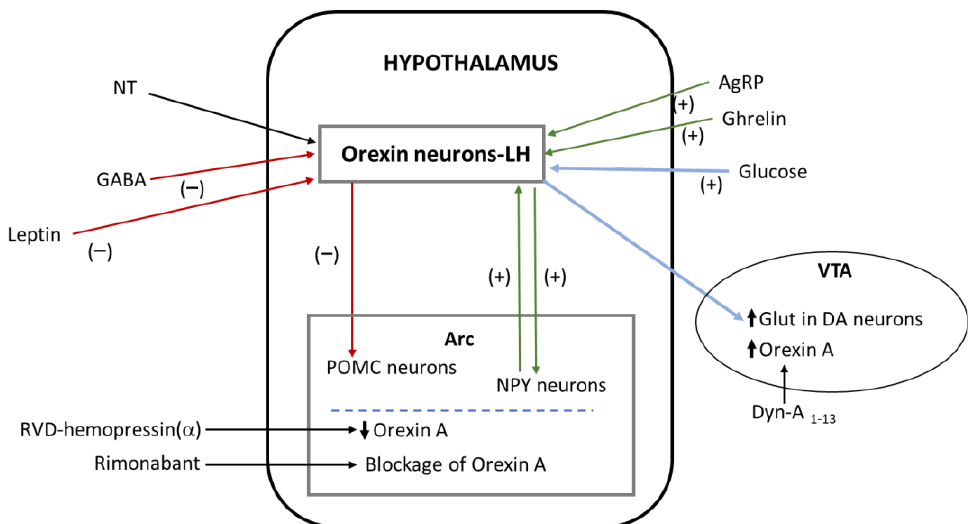
Figure 3. Interactions of orexin with other substances. Green arrows represent activation and red arrows represent inhibition. Blue arrows mean related actions: glucose activates the secretion of orexin by neurons of the lateral hypothalamus, and this activation leads to an increase in glutamate in dopaminergic neurons of the ventral tegmental area. Abbreviations: AgRP — agouti-related protein; Arc — arcuate hypothalamic nucleus; DA — dopamine; Dyn-A — dynorphin-A; GABA — gamma-aminobutyric acid; Glut — glutamate; LH — lateral hypothalamus; NPY — neuropeptide Y; NT — neurotensin; POMC — pro-opiomelanocortin; VTA — ventral tegmental area.